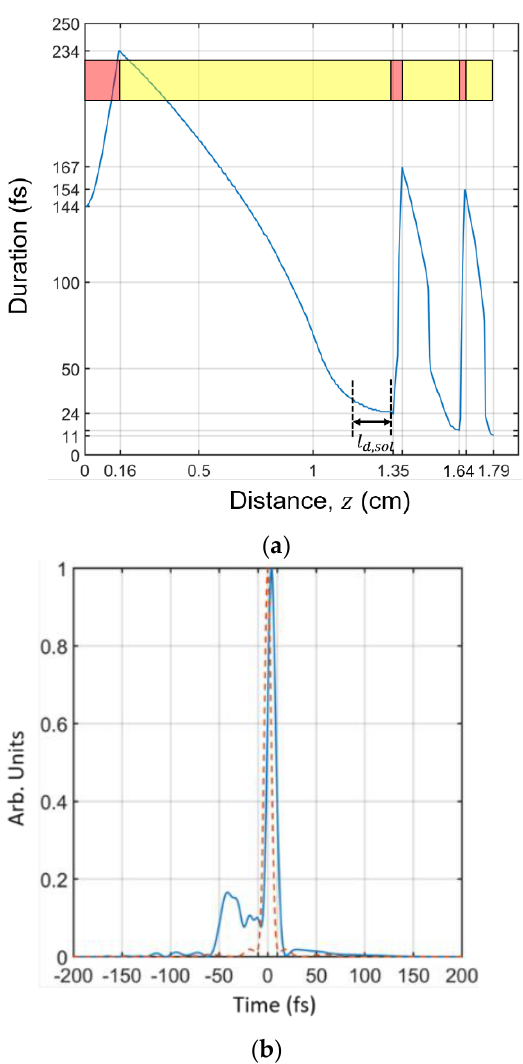
Figure 7. Numerical results. ( a ) The temporal 1/e duration as a function of propagation distance within the sign-alternating waveguide. An output duration of 11 fs is reached, yielding a compression factor of 12. Indicated is the dispersion length of the soliton, i.e., τ output pulse power profile normalized to the peak power of both the transform-limited pulse (red dotted curve) associated with the spectrum and the obtained pulse from the simulation (blue curve). The power profiles are plotted against envelope time. A transform-limited duration of 10 fs is obtained. The chip segments are shown at the top (red for ND segments, yellow for AD